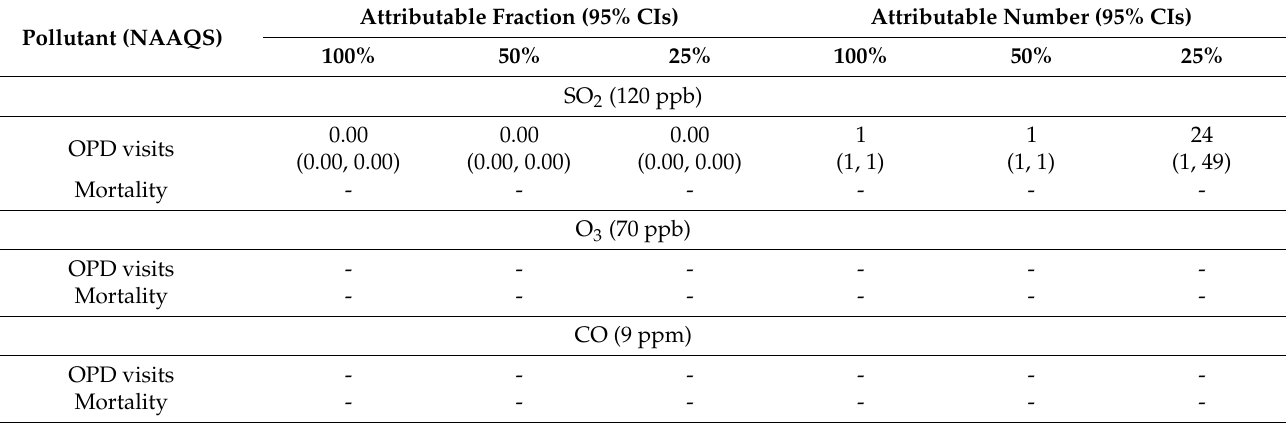
Table 15. Attributable fractions and attributable numbers of outpatient department (OPD) visits